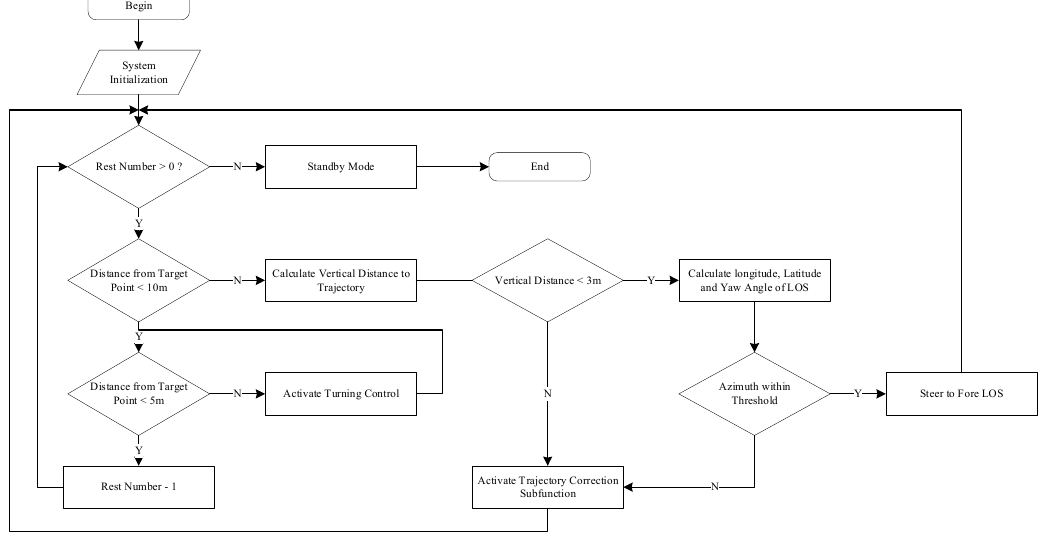
Figure 14. Flow chart of path following algorithm.